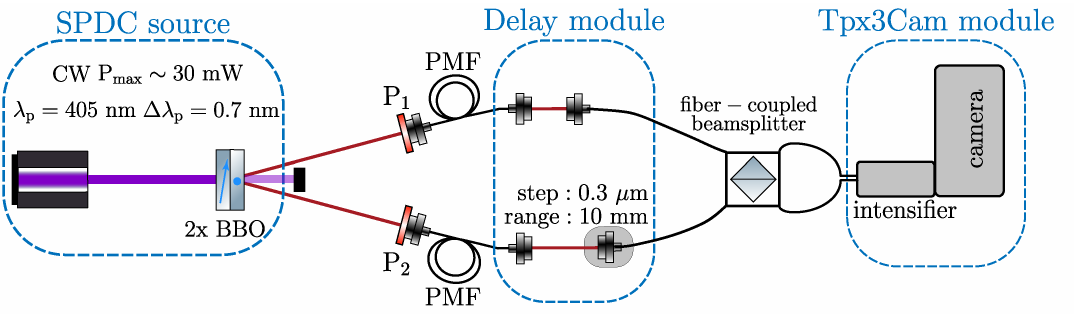
Figure 3. The sketch of the experimental setup. Pump beam produced by continuous-wave (CW) narrow-band ( ∆ λ p ≈ 0.7 nm) laser tuned to the wavelength of ( λ p = 405 nm) (spontaneous parametric down-conversion (SPDC) source). The created SPDC photons are coupled to polarization-maintaining fibers (PMF), where input polarization of photons in both arms is controlled by polarization plates P 1,2 . In the delay module, one can tune an optical path difference between the two legs using a motorized translation stage with 0.3 µ m minimal step and dynamic range of 10 mm. Photon counts are recorded with the intensified Tpx3Cam fast